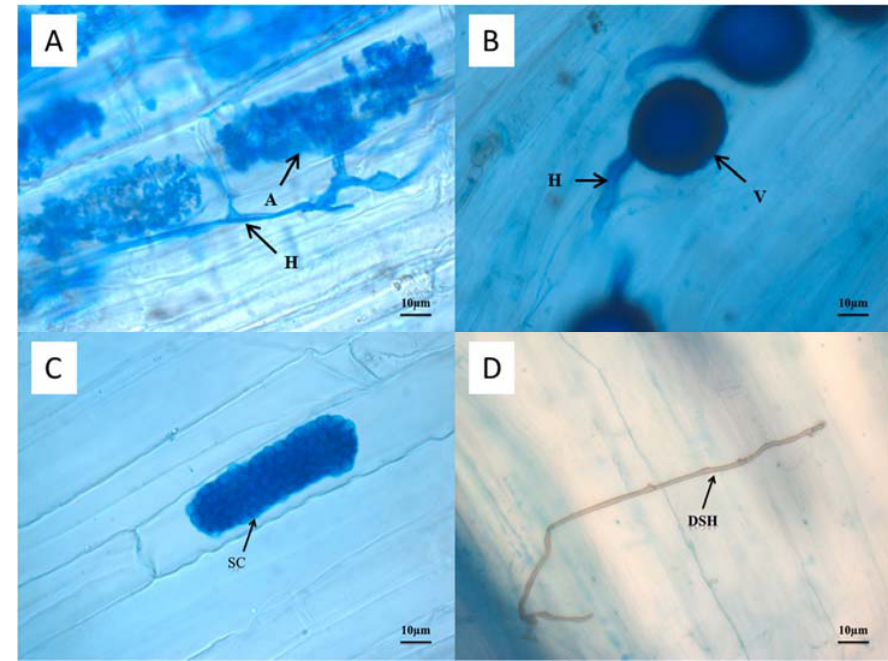
Figure 1. Arbuscular mycorrhizal fungi (AMF; A , B ) and dark septate endophyte (DSE; C , D ) structures used for identification and differentiation of both fungal types in Eragrostis tef roots. Labels: arbuscules (A), vesicles (V), AMF hyphae (H); Micro-Sclerotium (SC) and DSE hyphae (DSH). Size bars are 10 µ m.